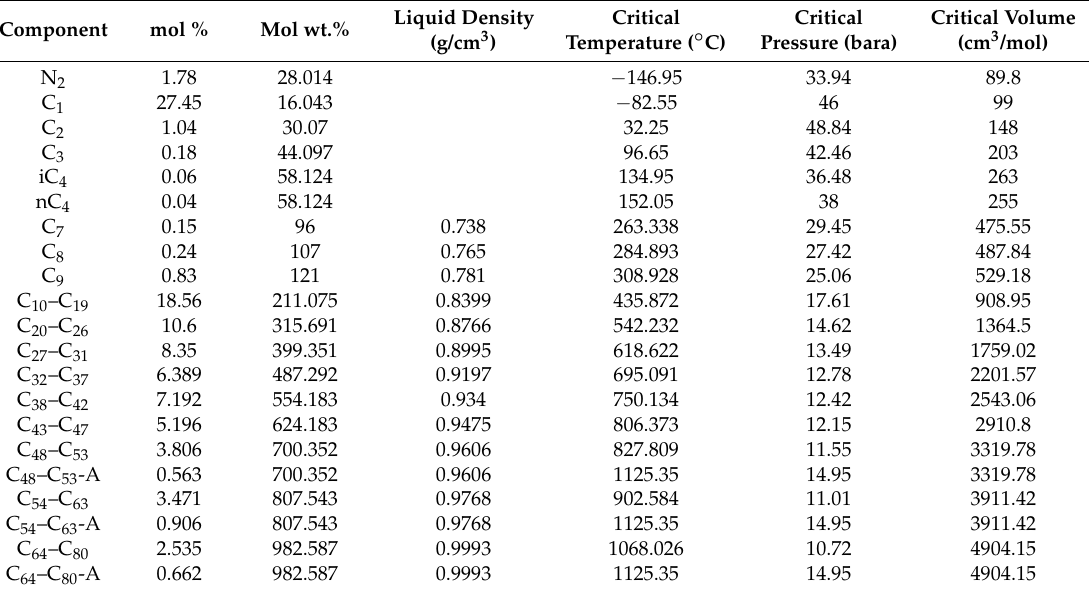
Table 2. Composition and critical parameters of pseudo-components in a shallow